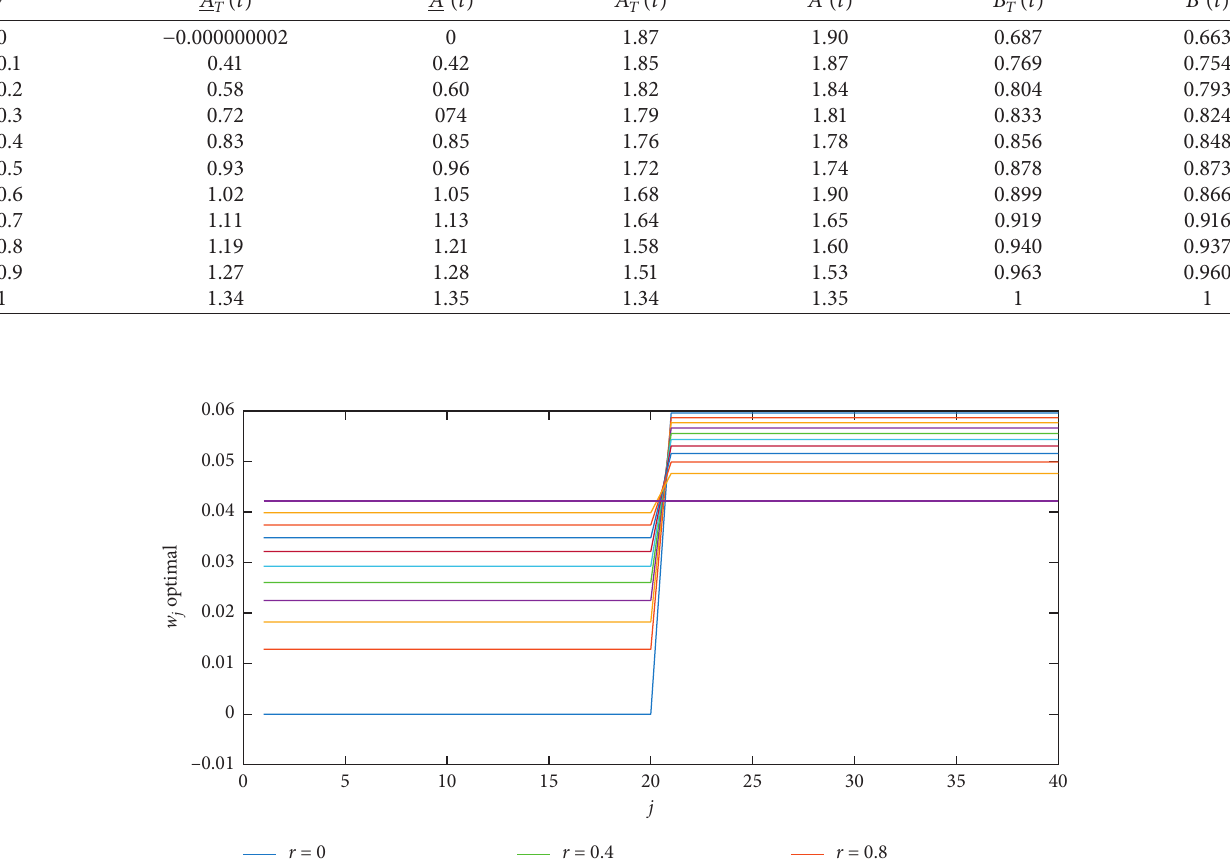
T approximated solutions for λ